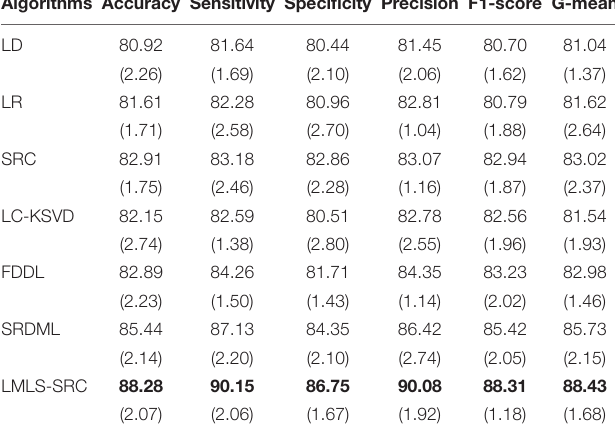
TABLE 2 | The comparative test results (with standard deviation) in binary classification task.